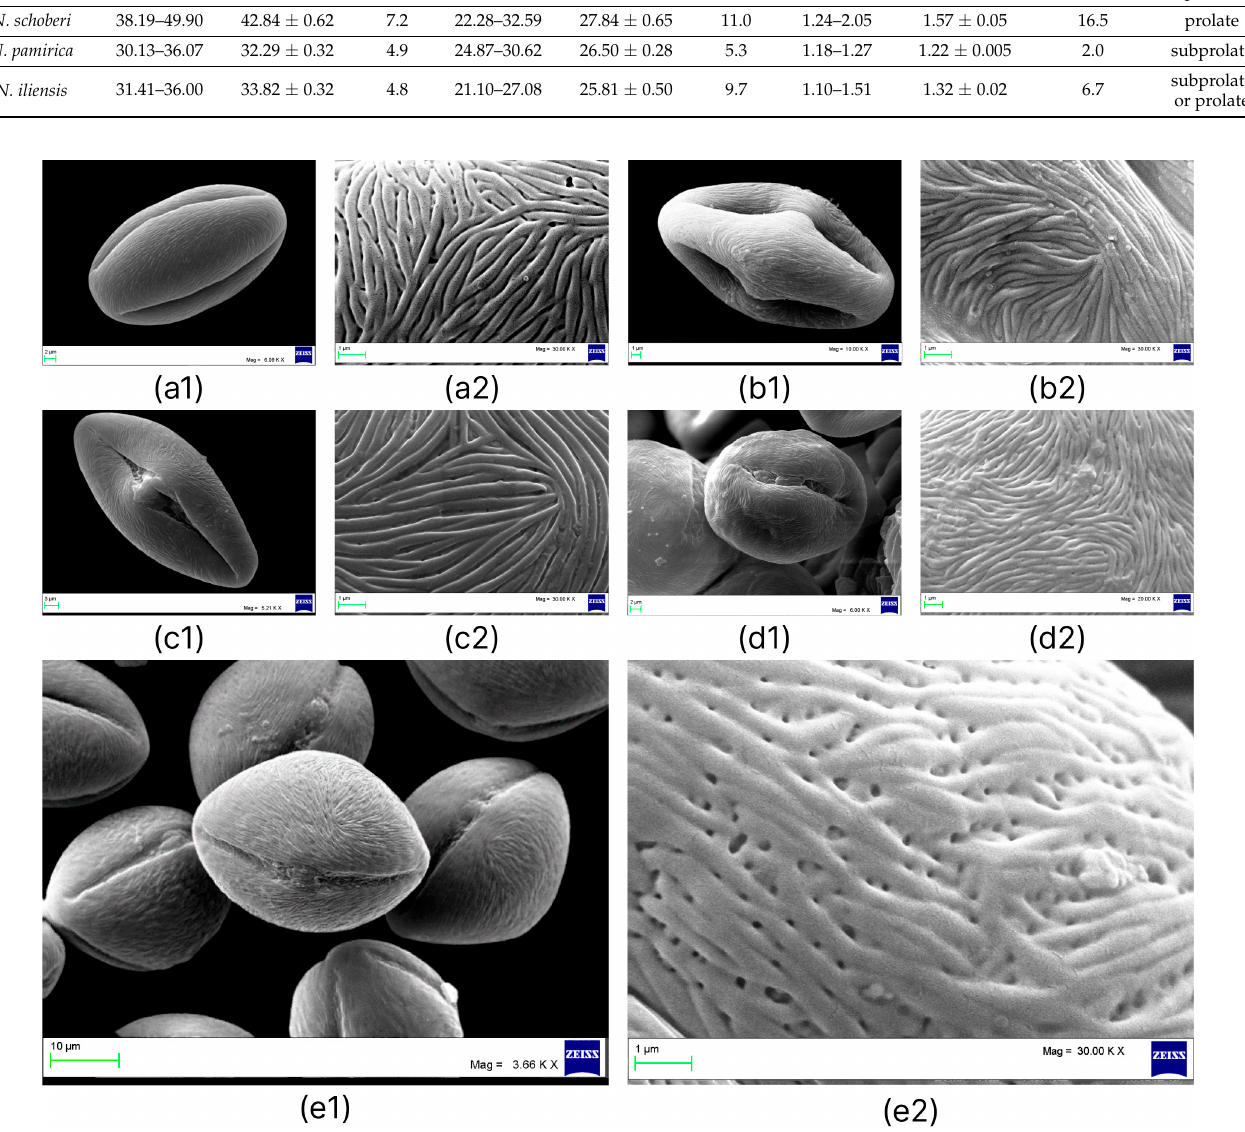
Figure 2. SEM analysis of Nitraria pollen grains: N. sibirica ( a1 , a2 ); N . komarovii ( b1 , b2 ); N . shoberi ( c1 , c2 ); N . pamirica ( d1 , d2 ); N . iliensis ( e1 , e2 ); 1 —equatorial view, 2 —details of the exine surface. Pollen grains of N. iliensis are medium in size and are radially symmetrical. The mean length of the polar axes of them is 33.82 (28.71–37.29) µ m, and the mean length of the equatorial axes is 25.81 (21.10–27.08) µ m. The mean P/E ratio of the pollen is 1.32 (1.10–1.53). They are subprolate or prolate in equatorial view and triangular convex or pseudo-hexagonal, circular in polar view and monad,